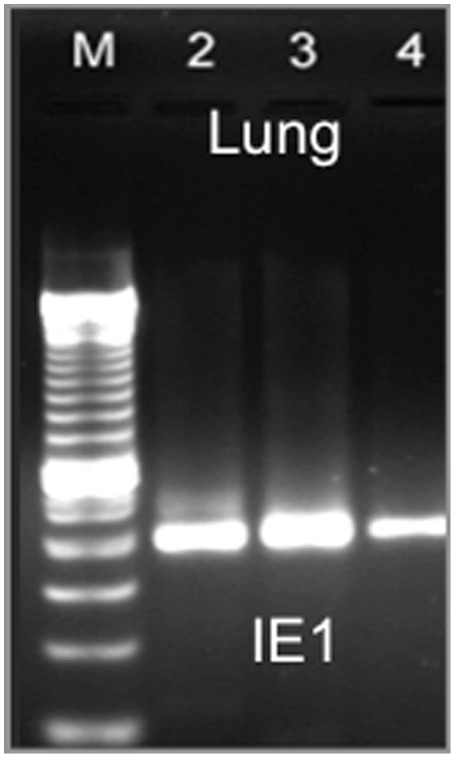
Lung tissues collected from chronically infected mice are positive for MCMV-specific IE1 DNA sequences.Representative 1% agarose gel showing positive signal for PCR assay for MCMV-specific IE1 gene sequences performed on three samples of lung tissue collected from three mice infected with MCMV for 12 weeks. (M = Molecular weight standards).